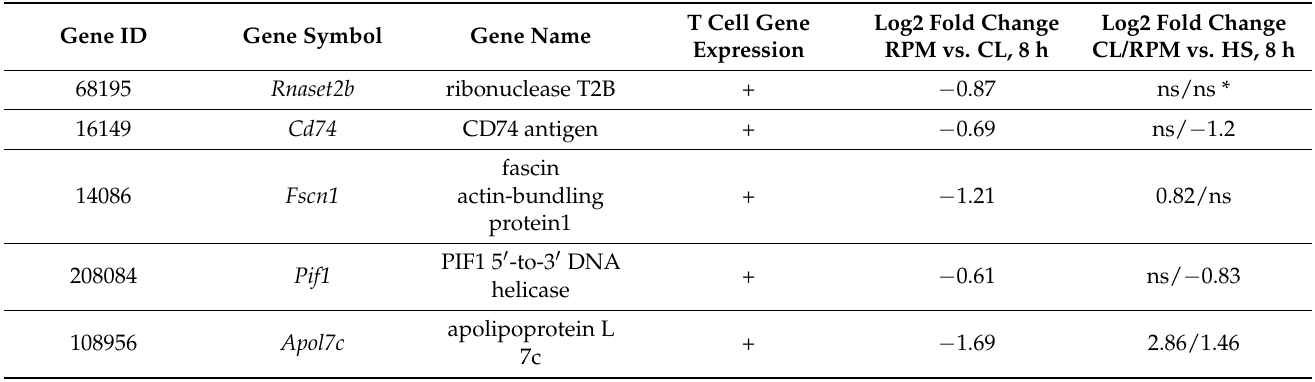
Table A3. The significantly down-regulated genes in CL platform versus RPM platform at 8 h of simulated microgravity